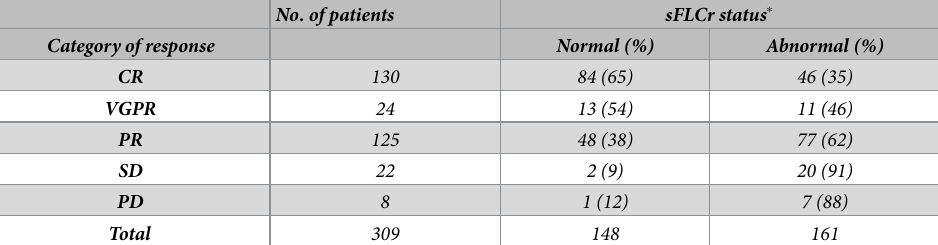
Table 2. Relationship between accepted response categories and sFLCr normalization.